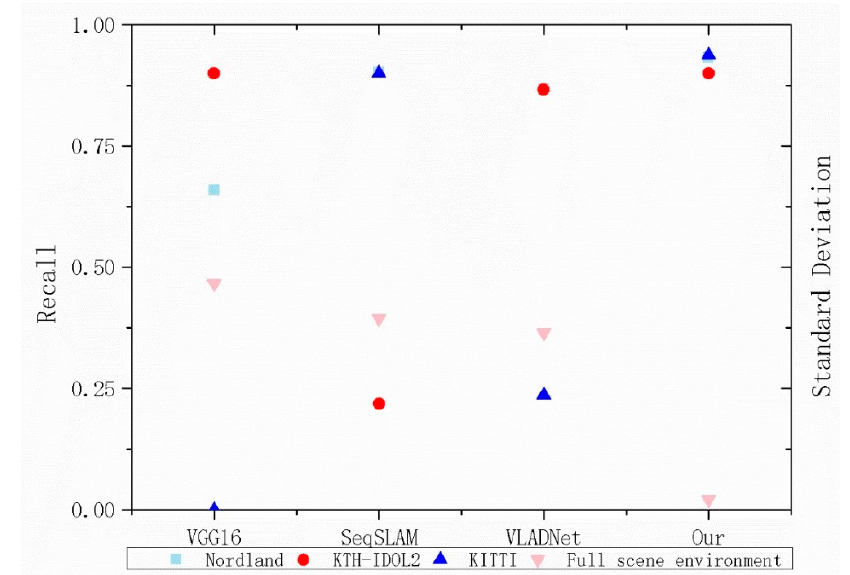
Figure 10. Recall and standard Deviation at 90% of precision of proposed method and the other three methods. Specifically, 0 recall at 90% of precision represents that the precision of the method has been below 90%.